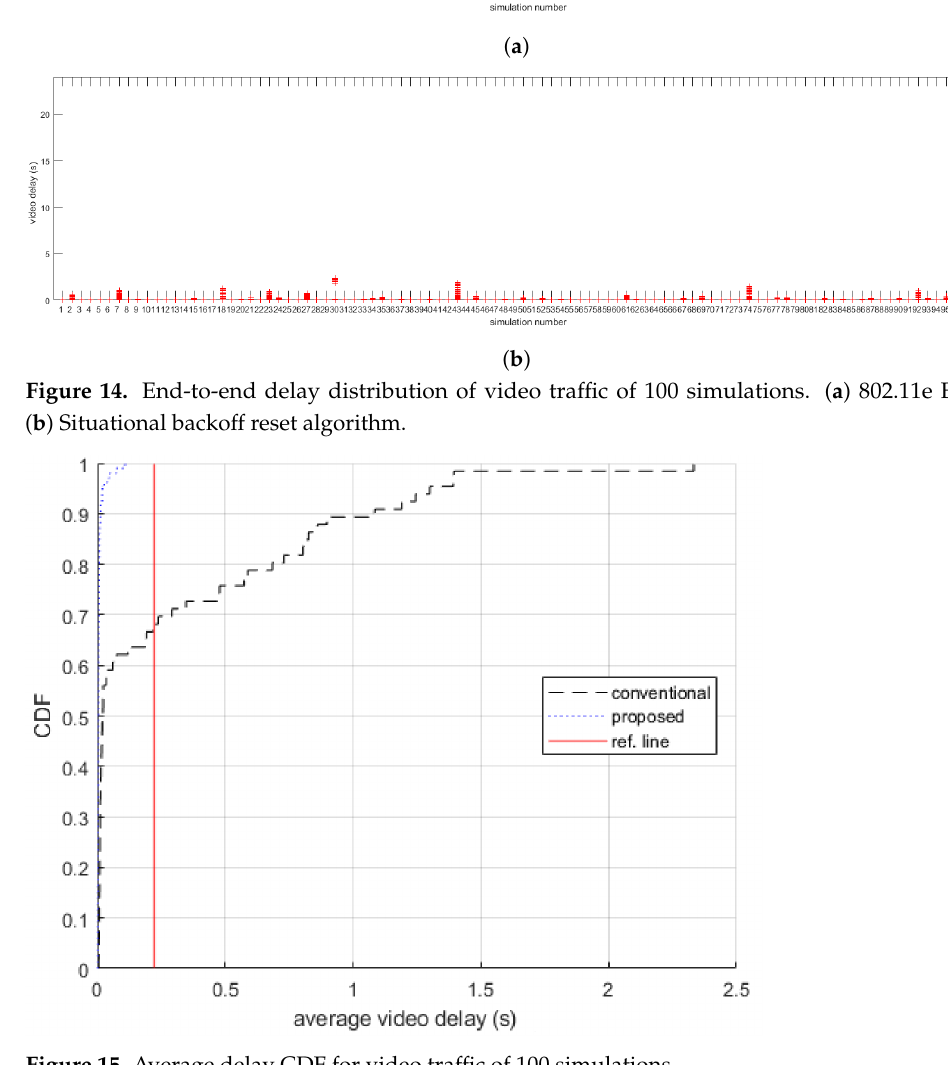
Figure 15. Average delay CDF for video traffic of 100